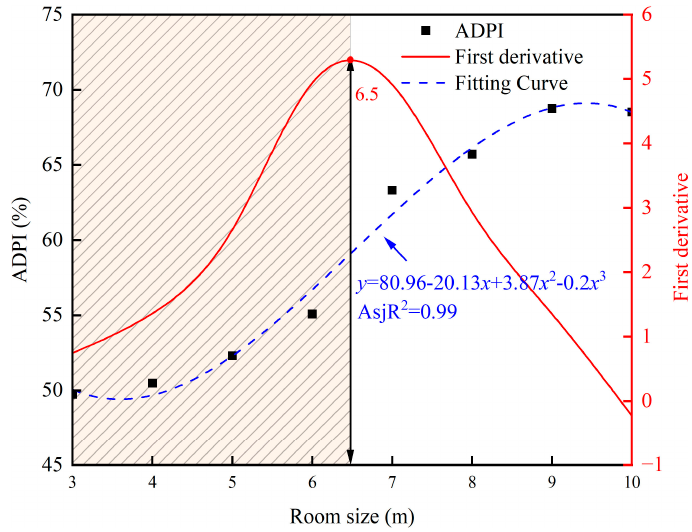
Figure 11. ADPI distribution of rooms with different widths.